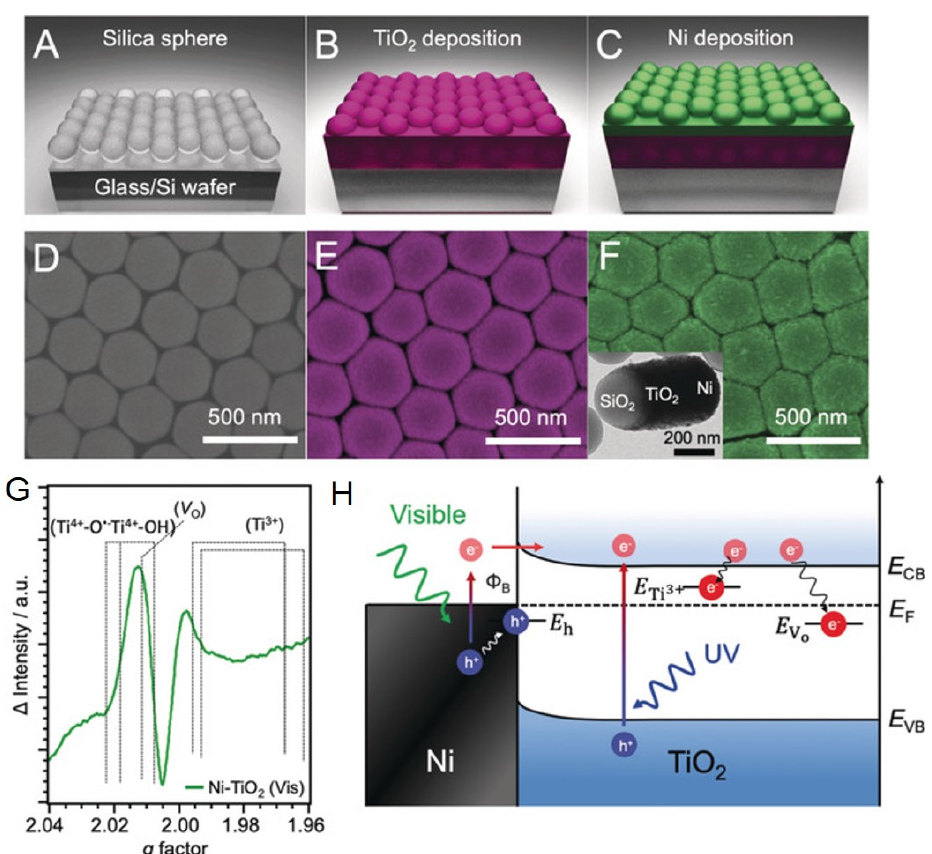
Figure 4. Fabrication and morphology of plasmonic Ni–TiO 2 substrates. ( A ) Spin-coating silica nanospheres on glass or a Si wafer; ( B ) deposition of TiO 2 on ( A ); ( C ) deposition of Ni on ( B ); ( D – F ) False-colored SEM images of the sample surfaces described in ( A – C ); ( G ) monitoring PMCT in Ni–TiO 2 heterostructures by X-band EPR spectroscopy; ( H ) illustration of PMCT in Ni–TiO 2 . Hot electrons (red) are transferred from Ni to TiO 2 upon the LSPR excitation of Ni and spatially separated from hot holes (blue). Reproduced from [69]. Copyright (2019), Wiley-VCH Verlag GmbH & Co. KGaA,